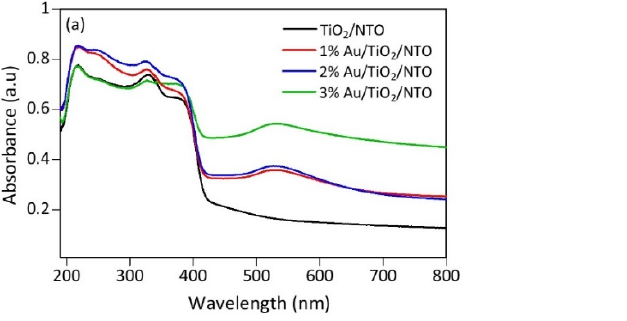
Figure 7. ( a ) Absorption spectrum UV-vis spectroscopy of TiO 2 /NTO with varying Au loading (1, 2, and 3 wt%), and ( b ) Tauc plot obtained through the application of Equation (6) for the samples.